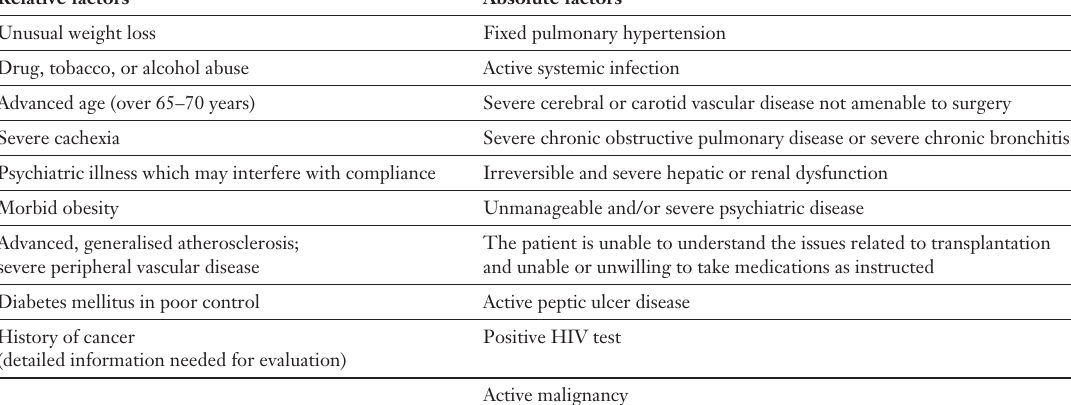
Table 1 Relative and absolute contraindications for heart transplantation.